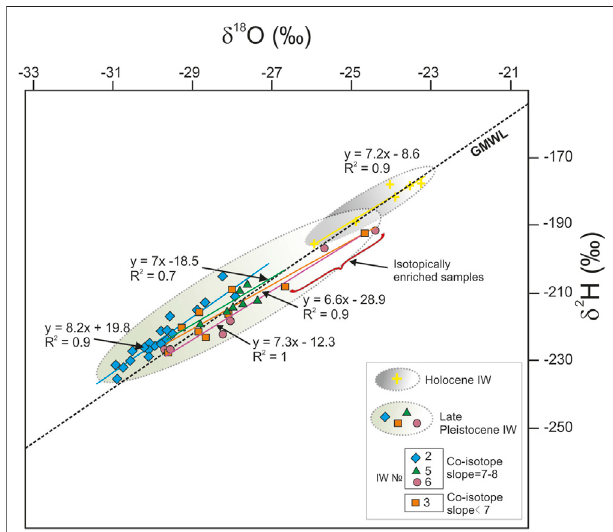
FIGURE 7 | Ratio of δ 18 O and δ 2 H values in late Pleistocene and Holocene ice wedges of an outcrop of a V terrace on the right bank of the Aldan River (Mamontova Gora outcrop). Sampling pro fi les 2 and 3 refer to the lower tier of the ice complex, 6 and 5 to the upper tier. GMWL, global meteoric water line.